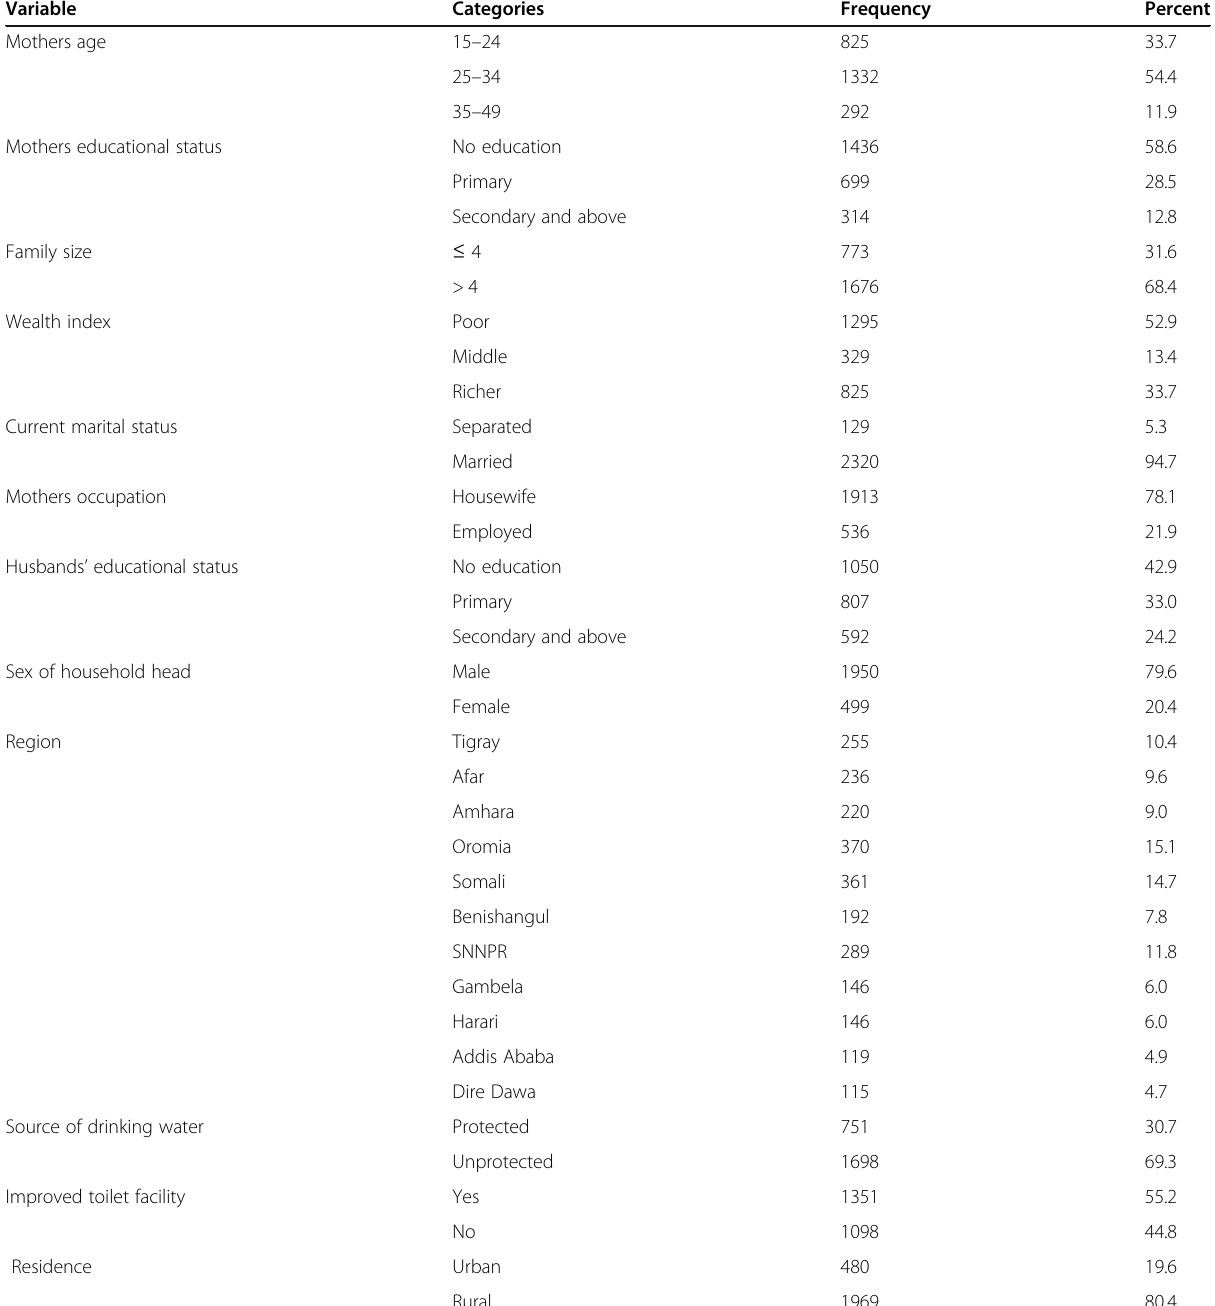
Table 1 Socio-demographic characteristics of the respondents, EDHS 2016